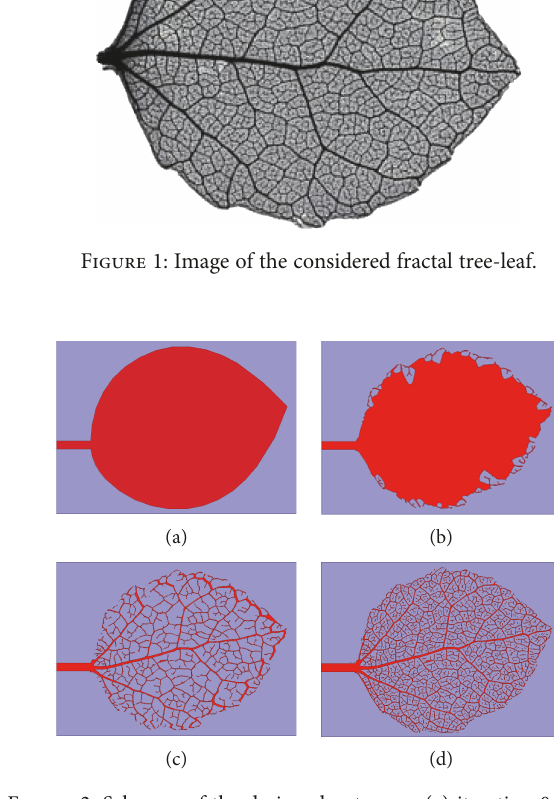
Figure 2: Schemas of the designed antennas: (a) iteration 0 (IT0),